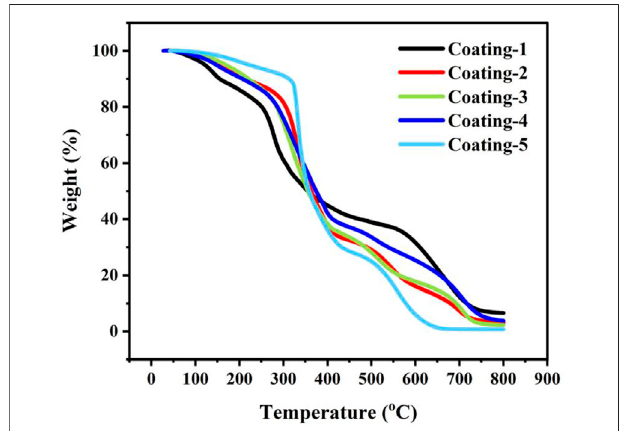
FIGURE 4 | TGA curves of different coatings (air atmosphere).